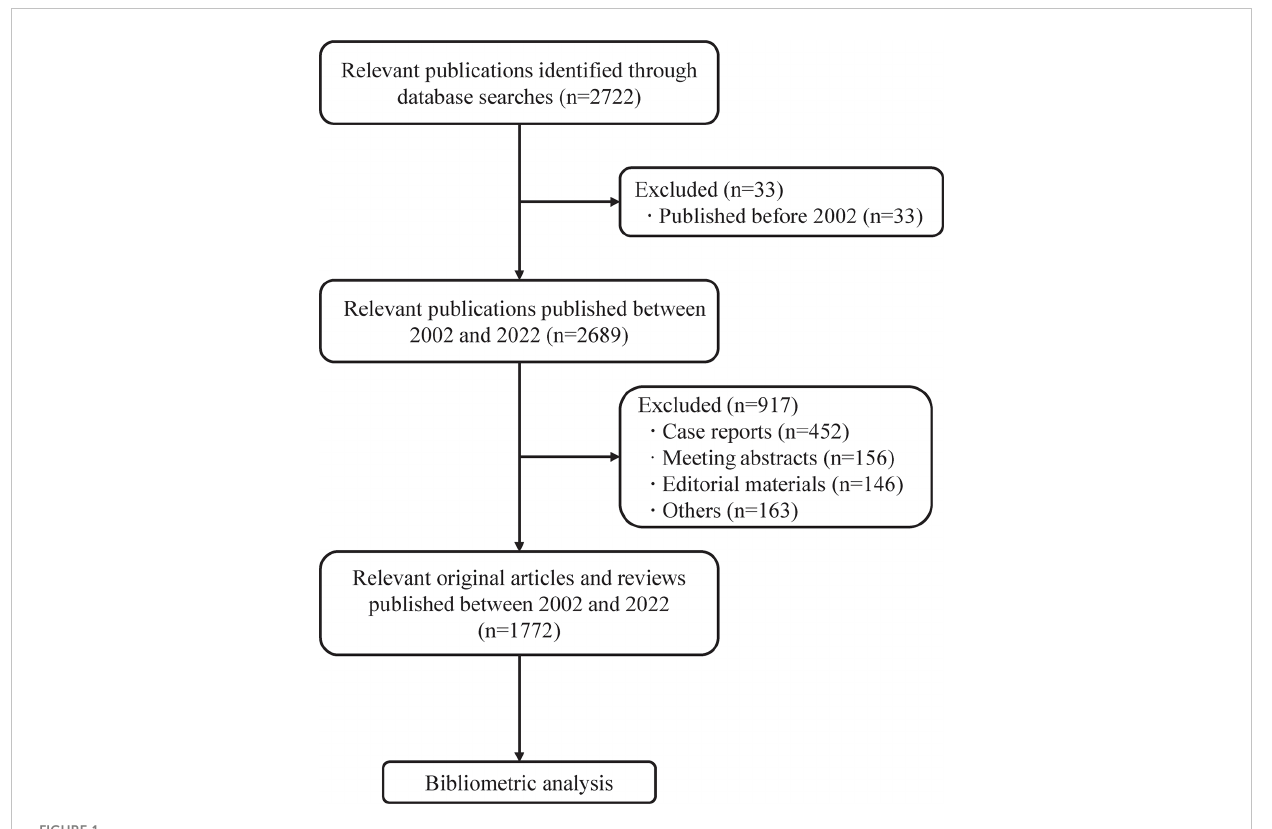
FIGURE 1 The inclusion and exclusion of publications on